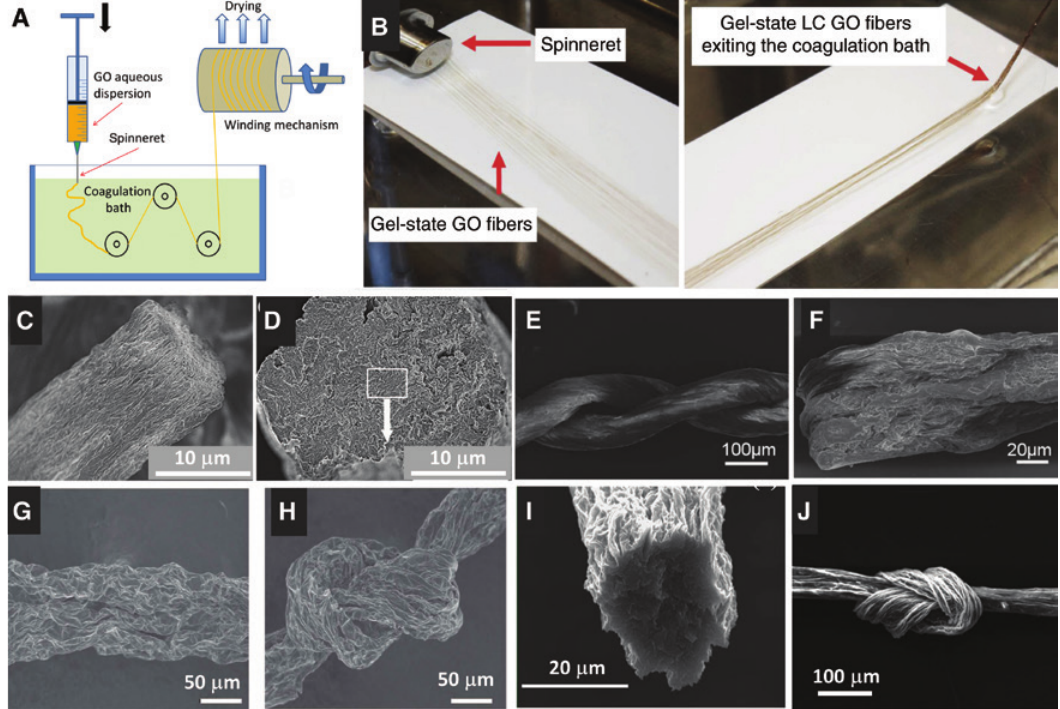
Figure 3: Wet spinning of GO dispersions and different morphologies can be obtained. (A) General scheme of the GO wet-spinning process. (B) Multiple spinneret GO fiber production [49]. Different fibers obtained by several groups: (C) and (D) GO by Jalili et al. [49], (E) and (F) chemically reduced GO by Cong et al. [50], (G) and (H) chemically reduced GO from Xu and Gao [51], (I) thermally reduced GO and (J) large flake GO from Xiang et al.